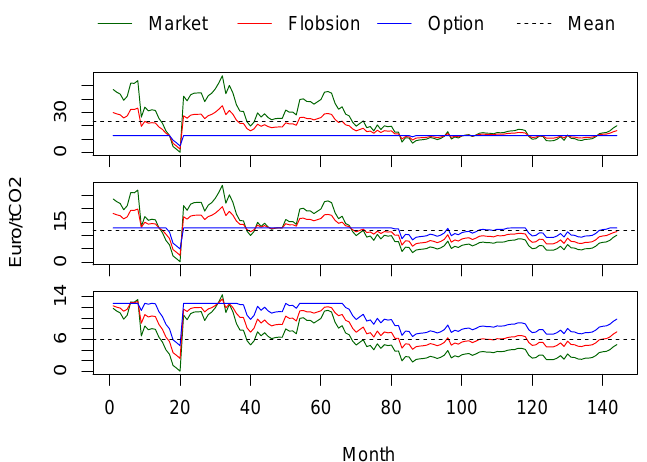
Figure 3. The total amount paid for emissions offsetting depending on the date (month since August 2005) in three cases: just paying a market price, using an option or a flobsion for three price scenarios: original historical prices (middle panel), those doubled (top panel), and halved (bottom panel).